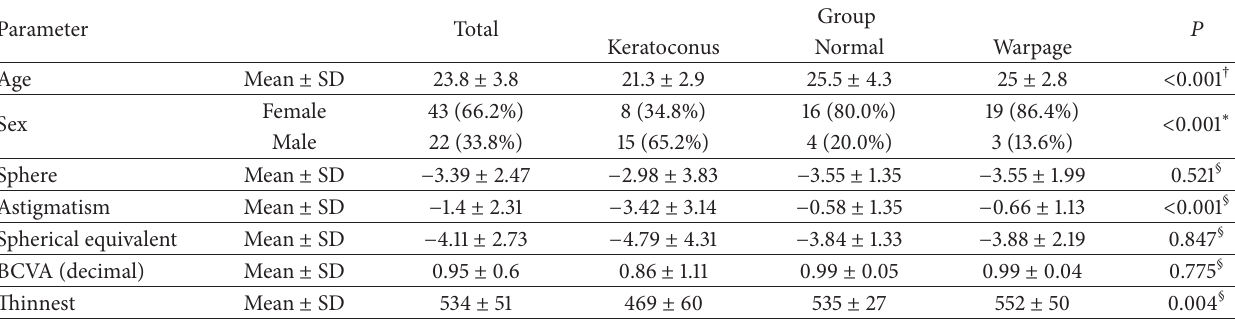
Table 1: Demographic data according to the final diagnosis.